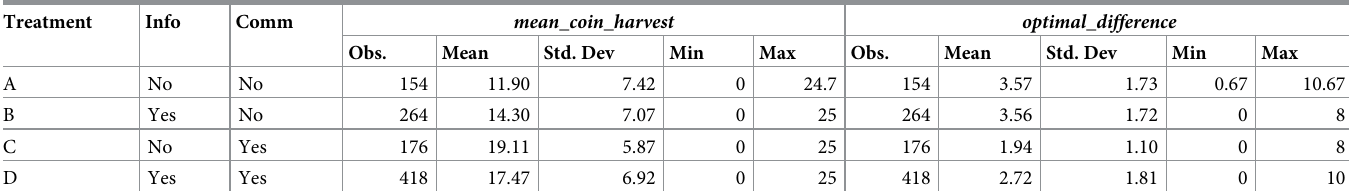
Table 2. Treatment information, group numbers and performance. Treatment